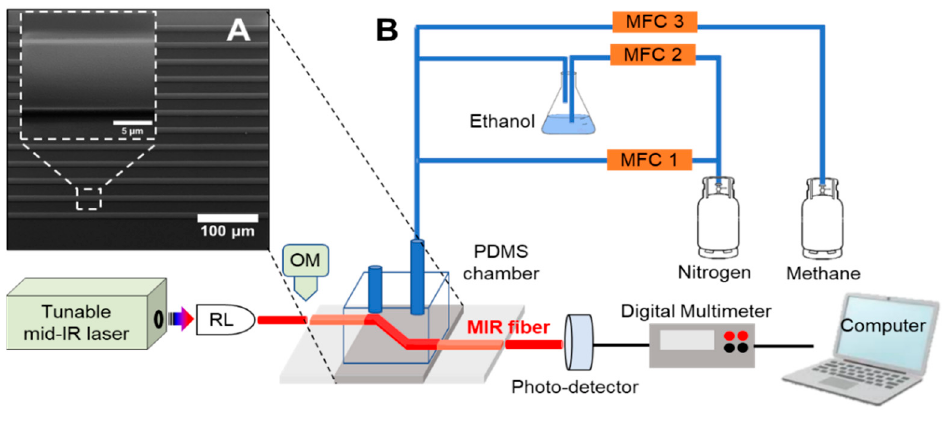
Figure 1. Top-view SEM image of waveguides (WGs) ( A ) and schematic illustrating gas measurement setup ( B ).